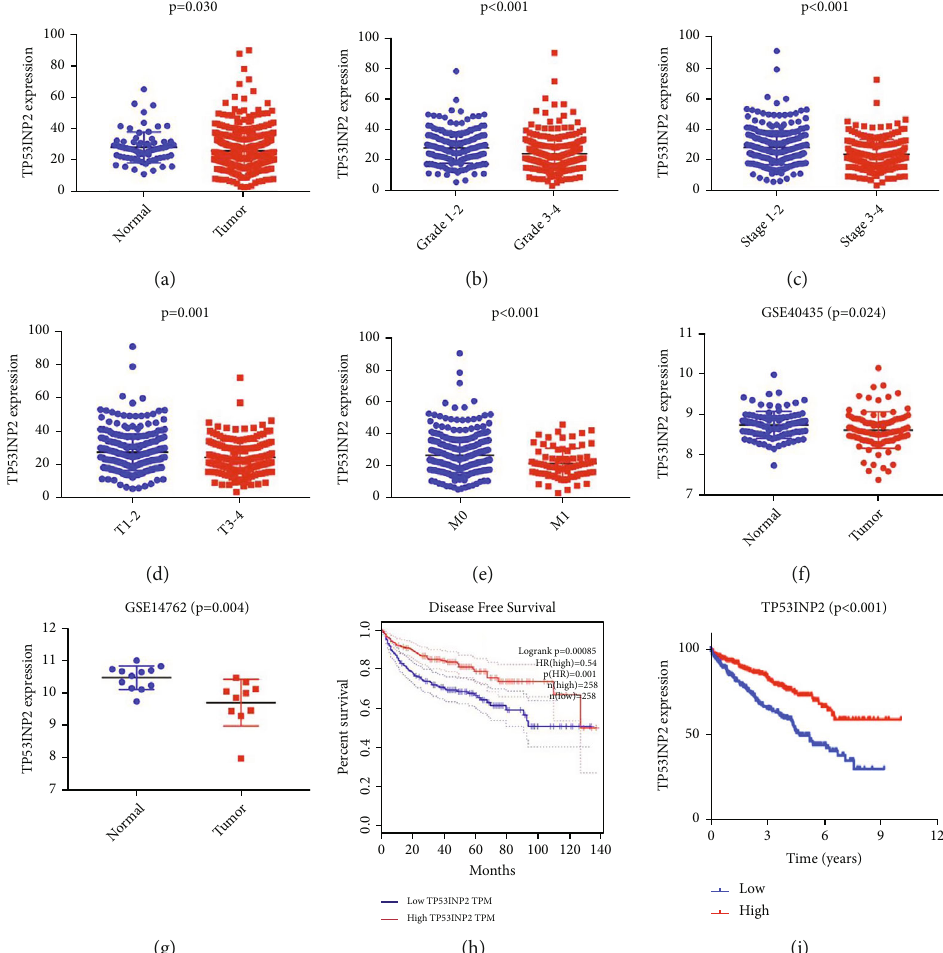
Figure 5: TP53INP2 expression and ccRCC patients ’ clinical data from the TCGA dataset and the GSEA analysis. The TP53INP2 expression in ccRCC tissues (a), Fuhman grade (b), American Joint Committee on Cancer (AJCC) stage (c), TNM status (d) and (e) based on TCGA dataset. (f) and (g) The TP53INP2 expression in ccRCC tissues based on GSEA analysis. (h) and (i) Low expression of TP53INP2 was associated with worse overall survival in Kaplan-Meier